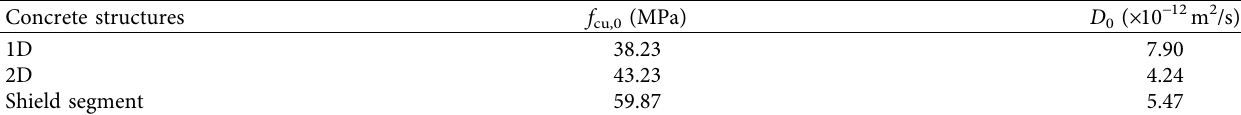
Table 7: Mix proportion of concrete.